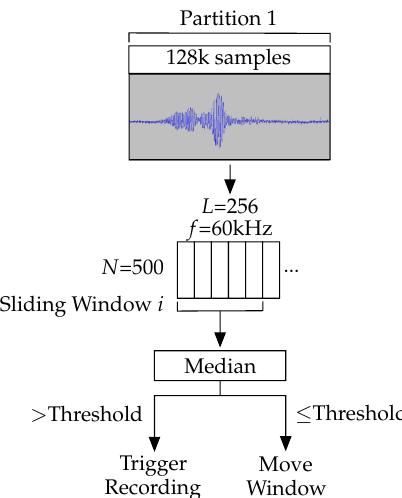
Figure 3. Overview of the data collection and bat detection process. Samples are collected and stored in a partition of the SRAM. Once full, the collected samples are fed into a 60 kHz Goertzel filter in windows of 256. A sliding window is run over the resulting series of responses. The sliding window takes the median response from five Goertzel filters and compares it to a threshold. It then either triggers a recording or moves the window along.